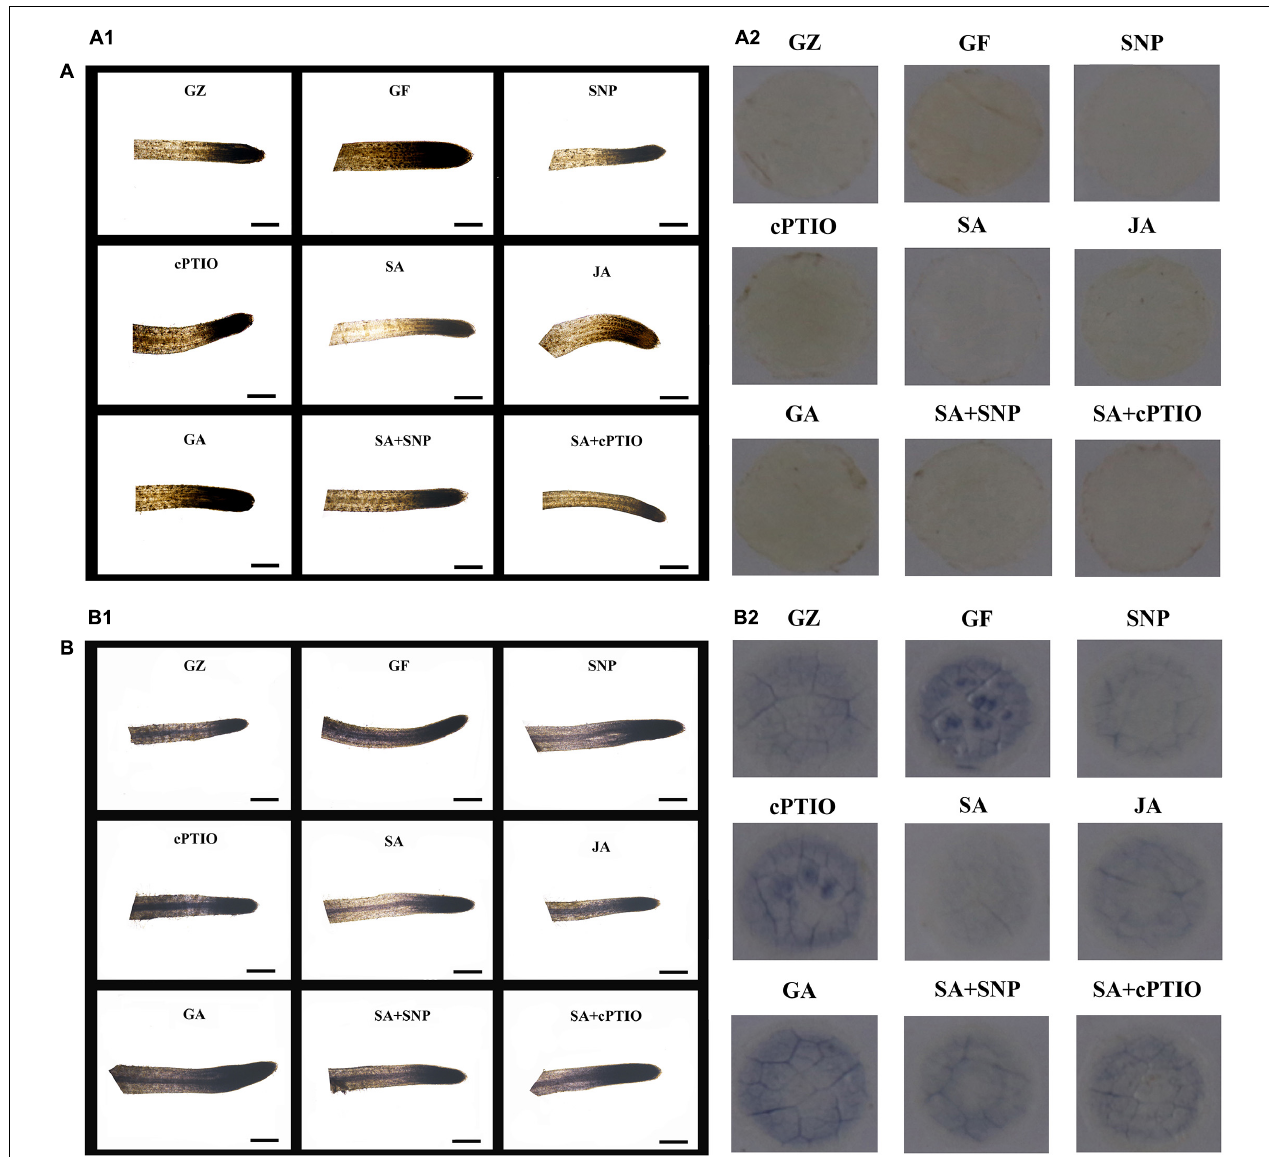
FIGURE 8 | In situ accumulation of H 2 O 2 and O 2 − by 3,3-diaminobenzidine (DAB) (A) and nitro blue tetrazolium (NBT) (B) . Staining of the roots (A1,B1) and leaves (A2,B2) after the respective treatment of NO effectors and/or phytohormones under the photovoltaic condition (GF) and the normal light condition (GZ). The figure is representative of ten segments stained in each